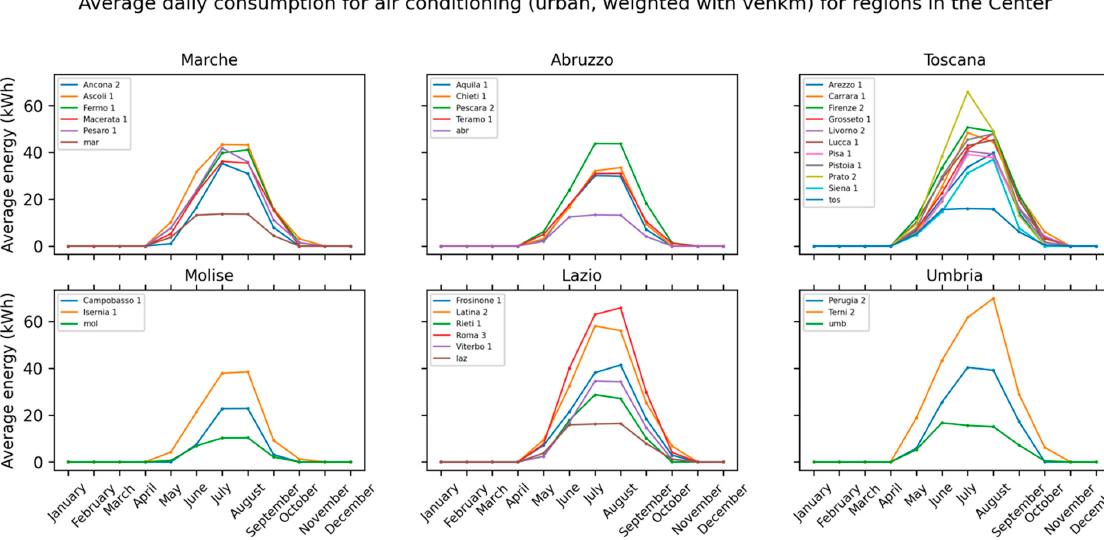
Figure 9. As Figure 7 for Southern Italian Regions. The impact of the mileage distribution is apparent. As a matter of fact, some regions are characterized by roughly constant climatic variables through the entire territory, as in the case of Liguria, shown in the bottom left panel of Figure 7: the four province capitals are all close to the sea and have relatively small differences in latitude and morphology. Three of the four cities are classified as small cities, while Genova is classified as large. The resulting consumptions are consistent with the city classification, with similar contri- butions for Imperia, La Spezia, and Savona, while much higher consumptions are esti- mated for Genova. Similar results characterize the Lazio region, while the impact of the climatic differences is apparent in other regions, as for instance Basilicata or Umbria, where all the cities are associated with the same vehicle-km distribution, but show differ- ent consumptions due to variations in average temperature and humidity. These two ef-